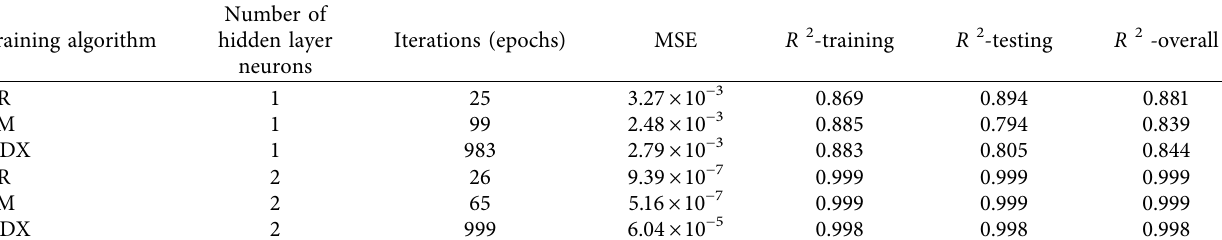
Table 3: Performance of training algorithms for prediction of milk yield and investment. Training